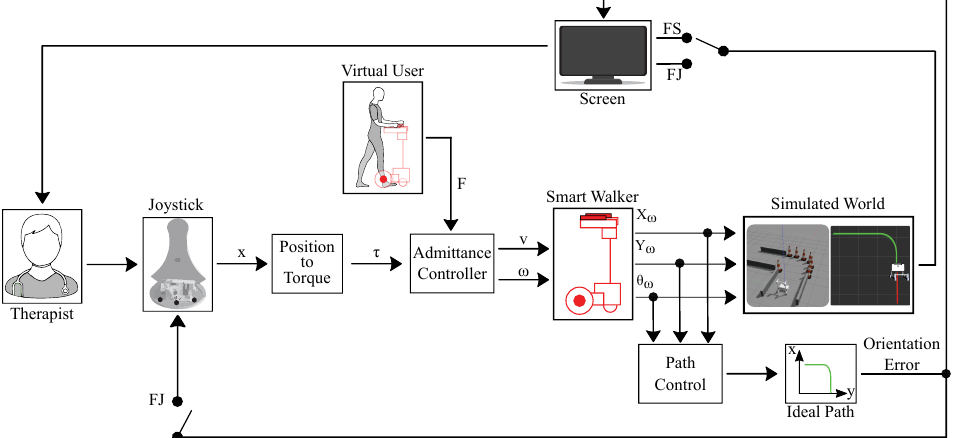
Figure 2. Illustration of the interaction system constituted by the feedback strategies, the path following task, and the simulation environment. x is the joystick position, τ is the virtual torque, F is the impulse force, v is the linear velocity, ω is the angular velocity, X ω is the x coordinate of the walker’s position, Y ω is the y coordinate of the walker’s position, and θ ω is the walker’s orientation. FJ refers to feedback on the joystick and FS to feedback on